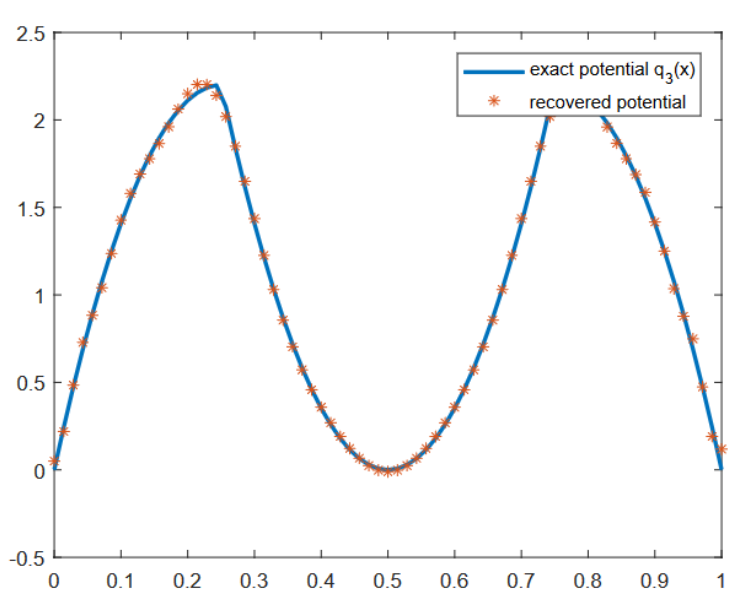
Figure 4. Potential q 3 ( x ) recovered from the data of type (3) given at 60 points ρ k distributed uniformly on the segment [ 0.1 + 0.1 i ,15 + 0.1 i ] and N =